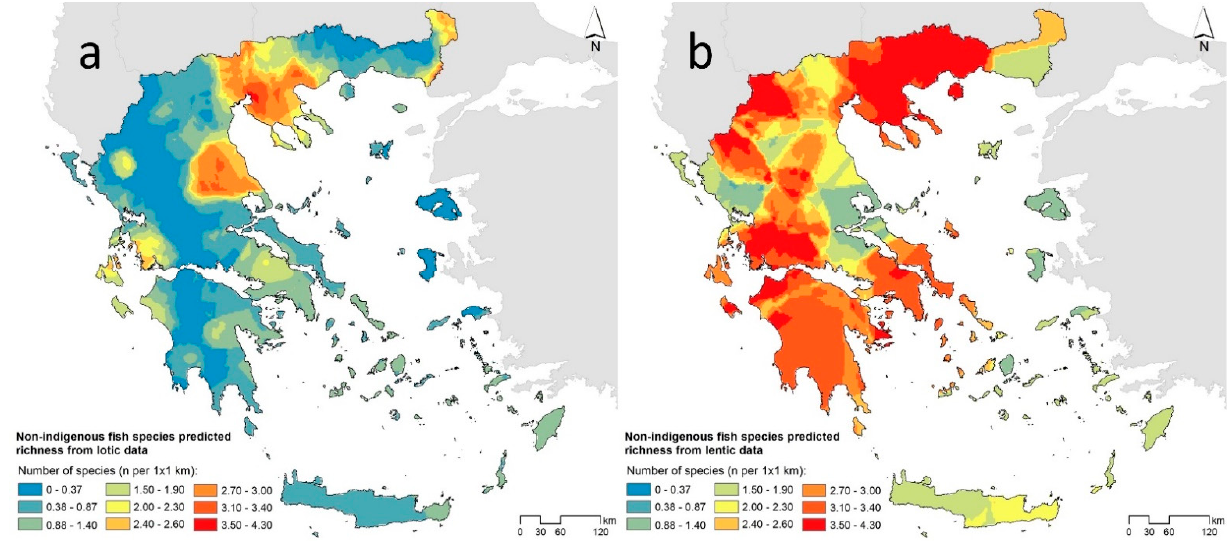
Figure 3. Patterns of the predicted richness of non-indigenous fish species derived from (a) lotic data and (b) lentic data.